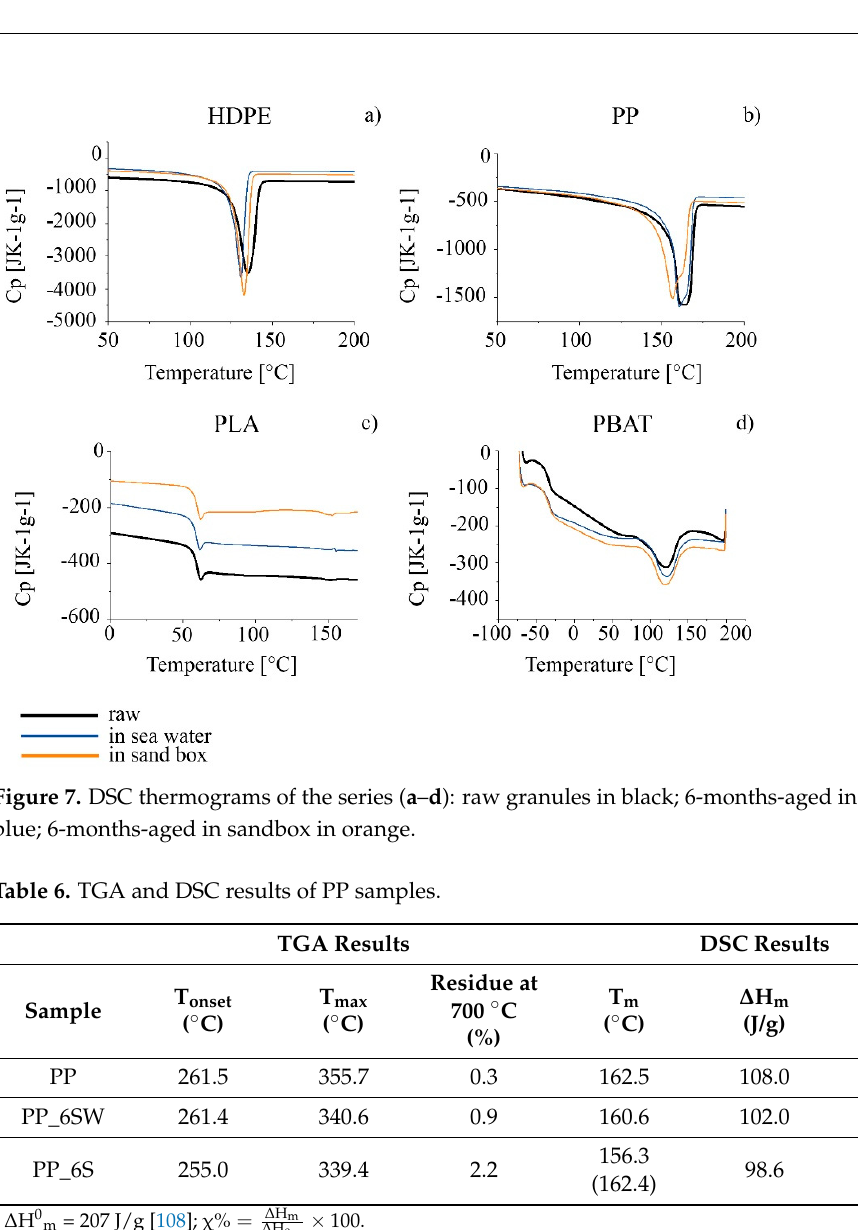
Table 5. Significant temperatures from TGA and DSC curves of HDPE samples.